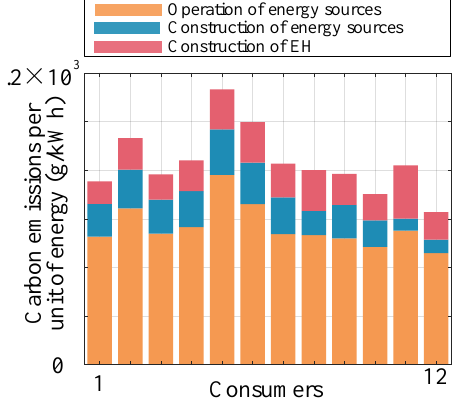
Figure 9. Carbon emissions per unit of energy.